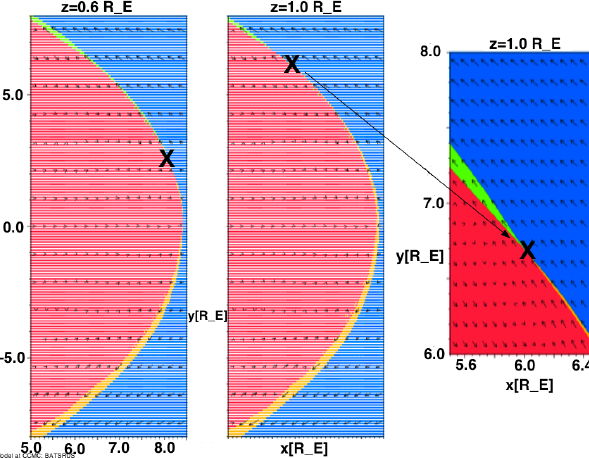
Fig. 12. Flow velocity in the y direction ( v y ) for z cuts ( z = − 2, − 1, 0, 1, 2 R E ) seen from two different perspectives: from above (top) and from below (bottom). Blue and red mean roughly dawn- ward and duskward flow, respectively. Red and blue lines have been drawn to indicate the flux tube shape.